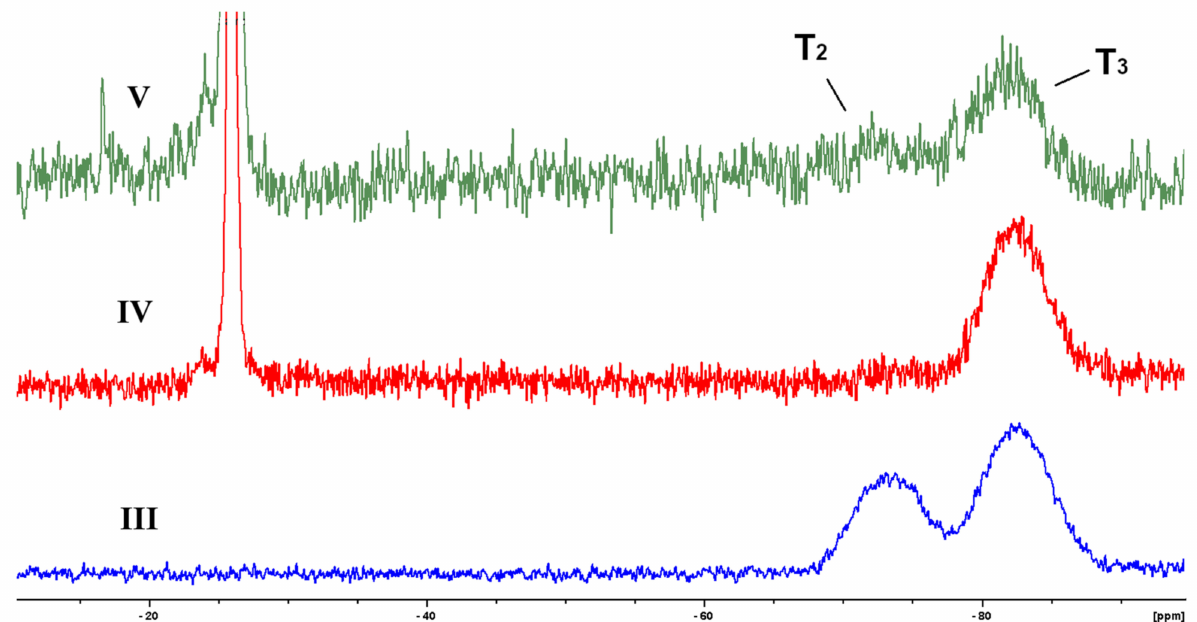
Figure 4. 29 Si solid state NMR of III, IV and